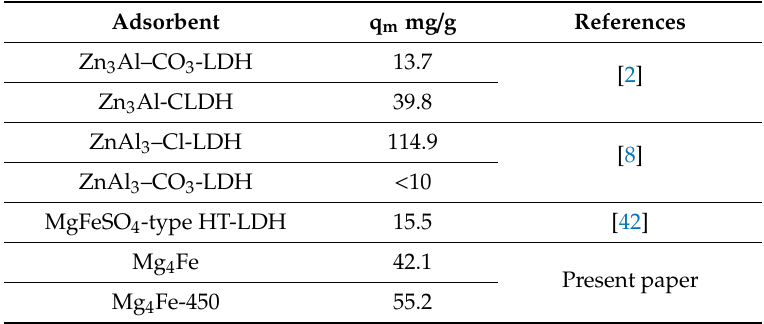
Table 6. The comparison between the adsorption capacities of similar adsorbents developed for the treatment processes of aqueous solutions containing MoO 42 −